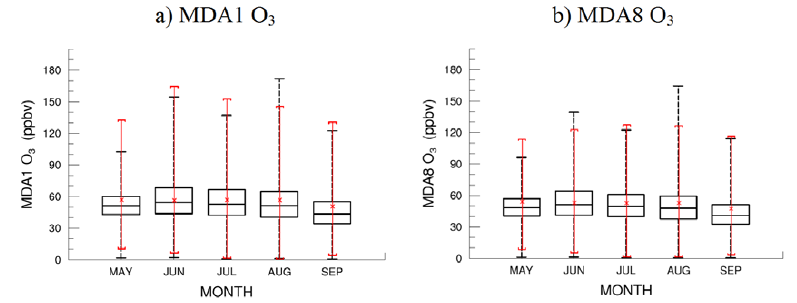
Fig. 4. Statistical distributions of ozone concentrations for the months of MJJAS in 1999–2001: (a) maximum 1-h (MDA1), and (b) 8-h average ozone (MDA1). The black color corresponds to the 1999–2001 CMAQ simulated value, where as the red color represents the CASTNET observed values from 1998 to 2002.